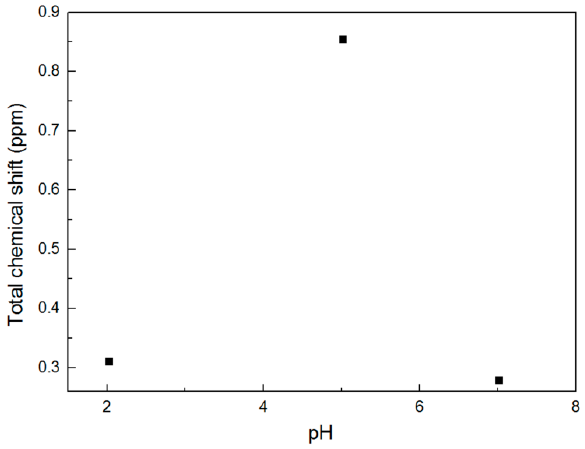
Figure 8. Total chemical shifts of characteristic 1 H-NMR signals measured at various pH values.